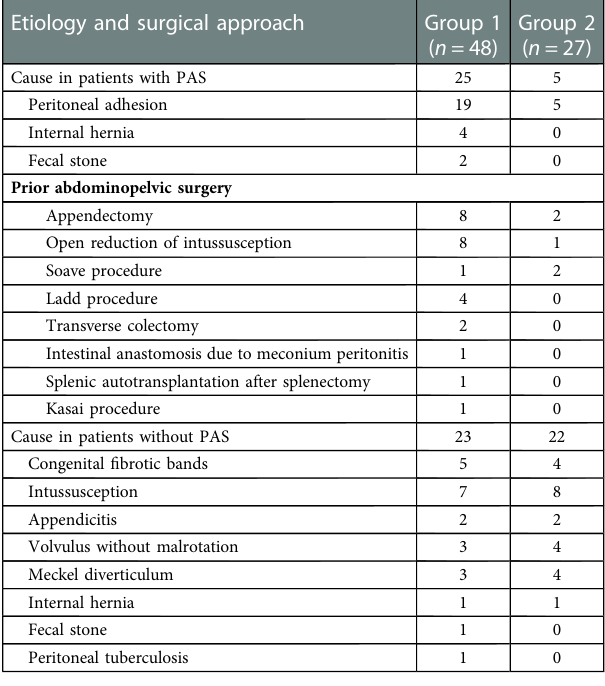
TABLE 2 Etiology of pediatric SBO patients with or without prior abdominopelvic surgery. Etiology and surgical